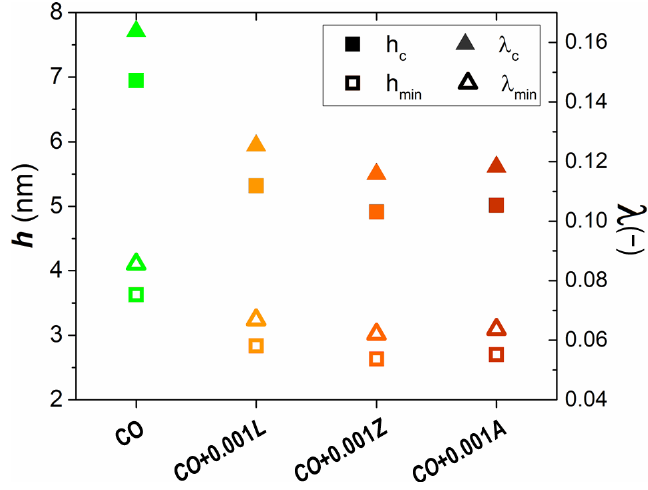
Figure 4. Central and minimum lubricant film (h) and lambda ratio (λ) of bio-lubricants.